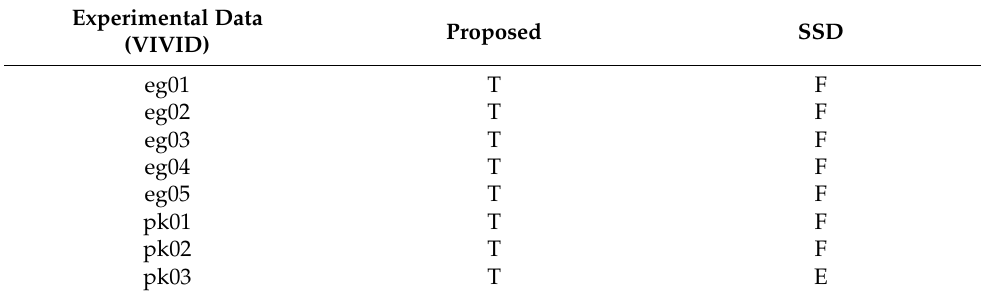
Table 1. Comparison between the SSD and the proposed mesh-based ghost identification method. Experimental Data